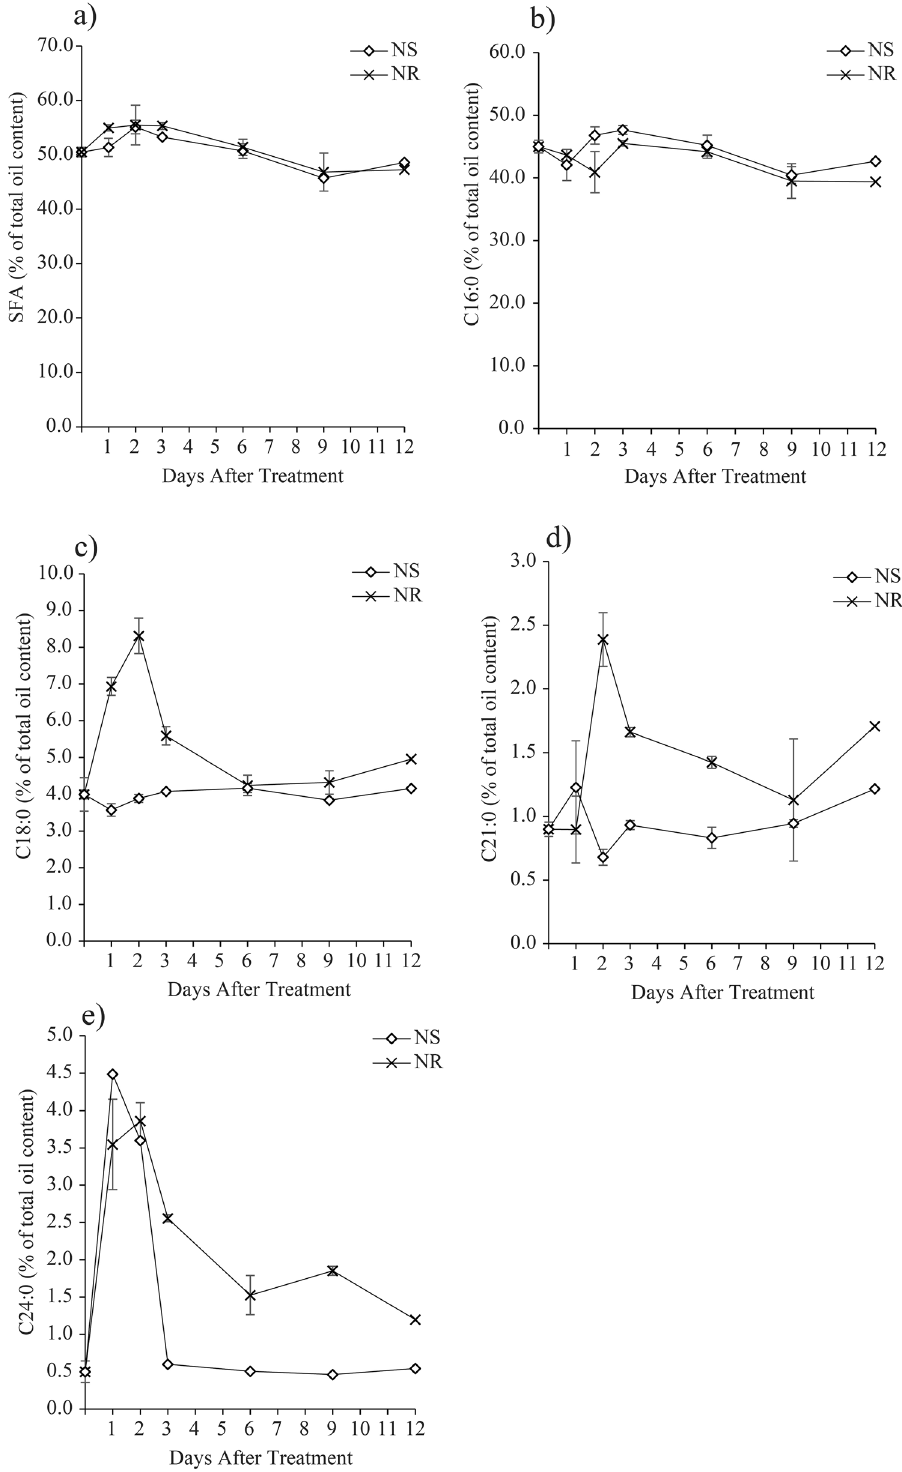
Figure 3. Effects of nitrate availability on saturated fatty acids (SFA) composition of M. gracile SE-MC4 cultivation during early (day 1, 2 and 3), mid (day 6 and 9) and late (day 12) treatment periods. ( a ) Overall SFA production, ( b ) percentage of C16:0, ( c ) percentage of C18:0, ( d ) percentage of C21:0, ( e ) percentage of C24:0 of M. gracile under NS and NR conditions. The values are presented as means ± standard deviation (SD) (n =